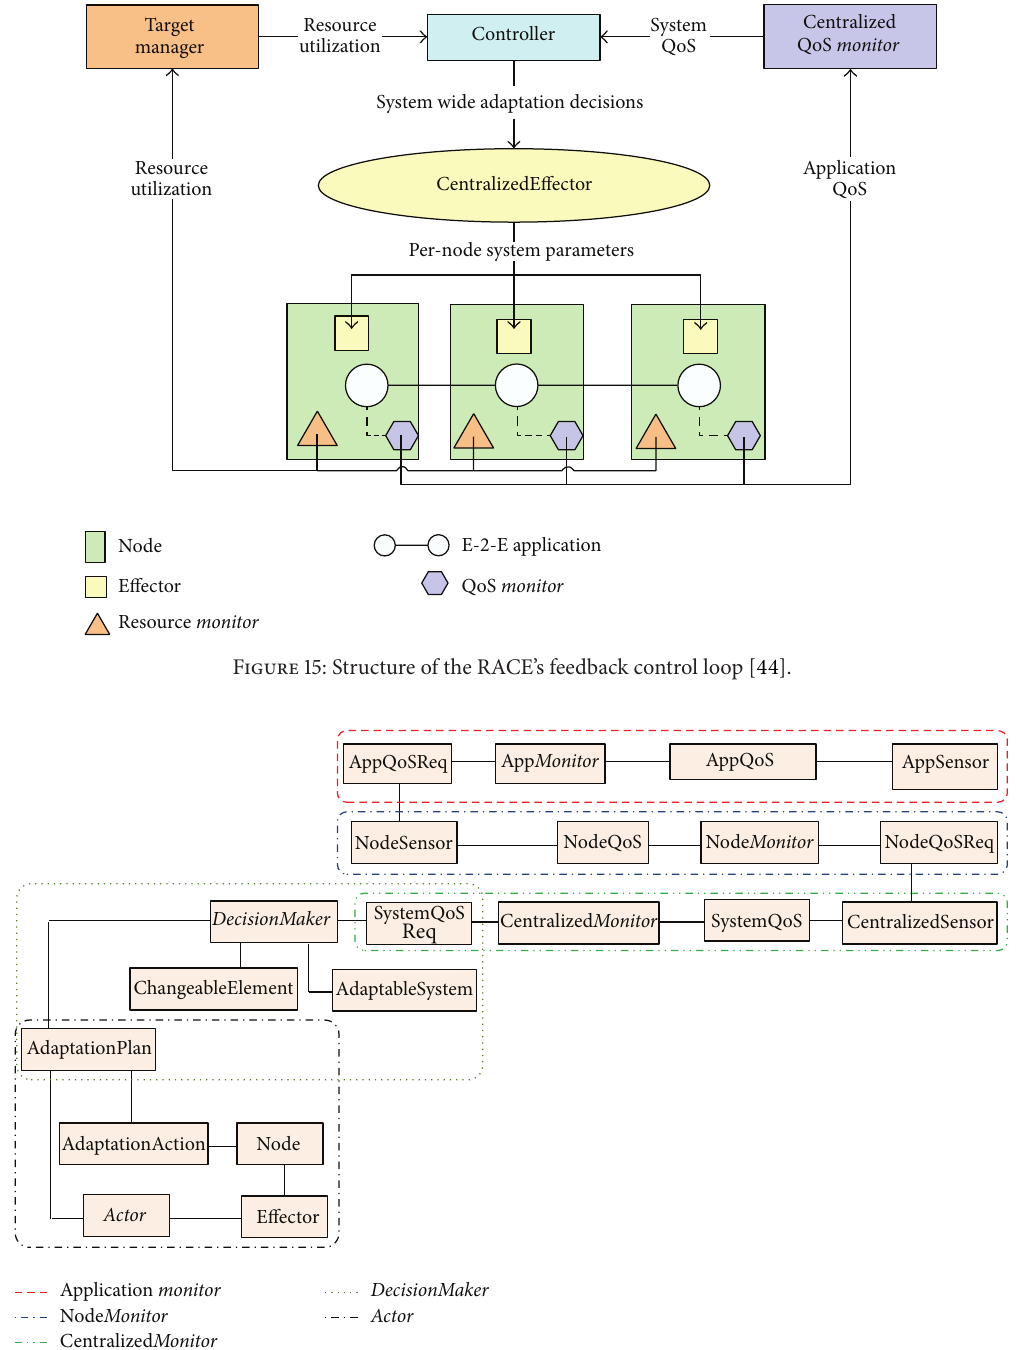
Figure 16: Patterns application to the RACE feedback loop for application QoS